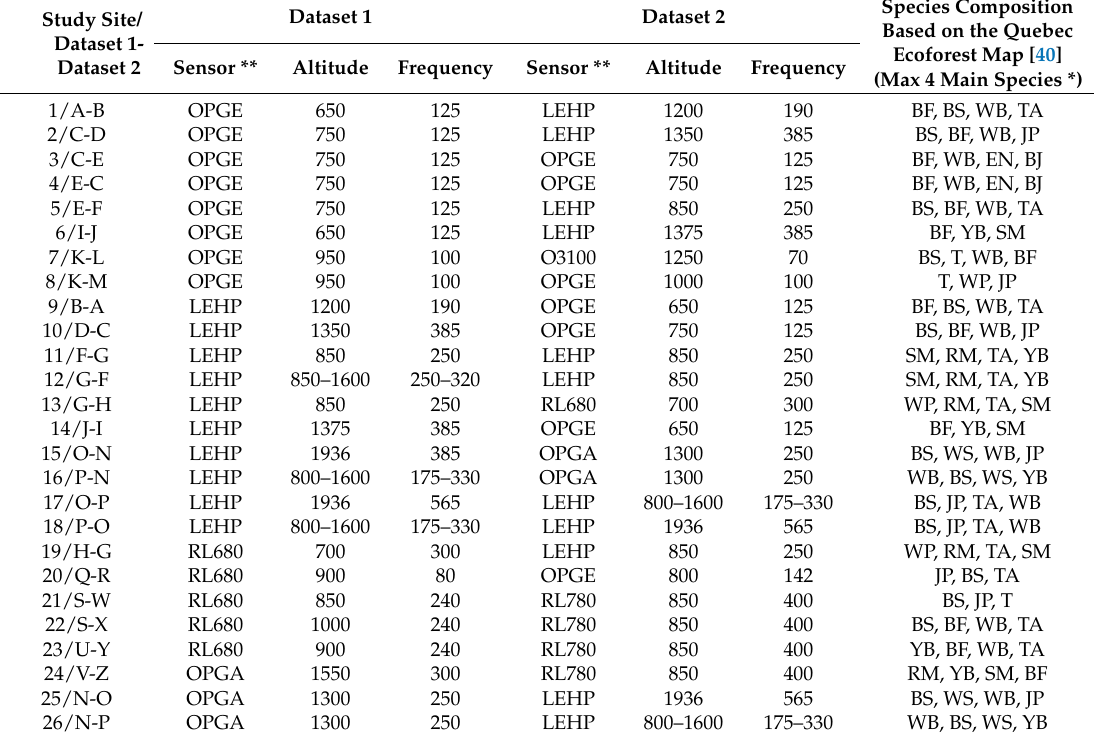
Table A1. Metadata of the 26 study sites used for the